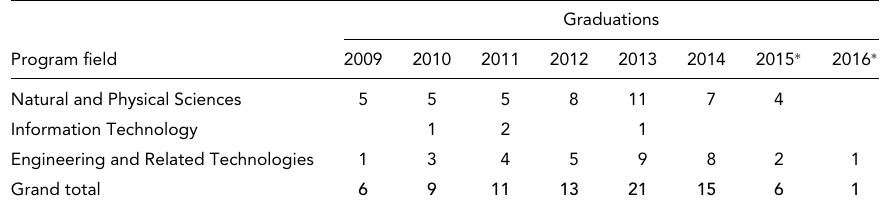
Number of Indigenous Students Graduated from STEM Programs from